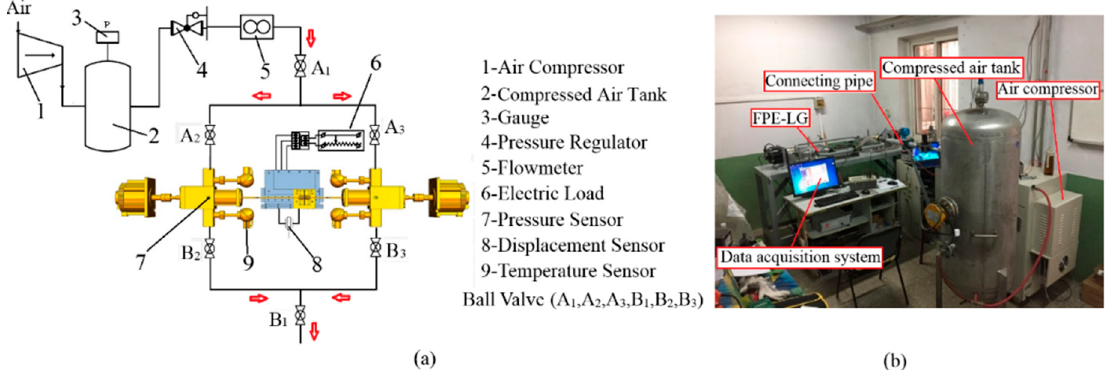
Figure 5. Air test rig of the FPE ‐ LG: ( a ) the schematic diagram of experimental system; ( b ) the picture of experimental system.